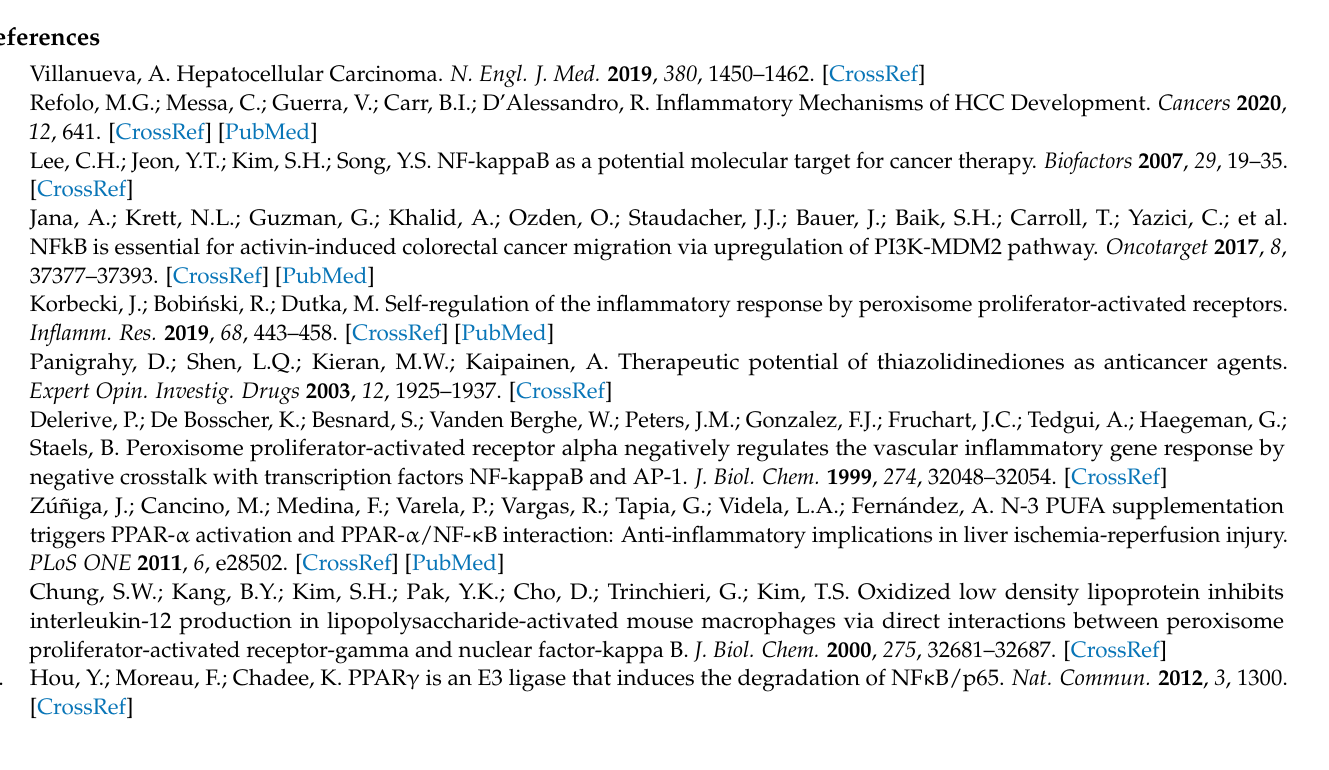
S2: Reagents used for cytoplasmic and nuclear fractions; Table S3: Antibodies list employed in the different methodologies; Table S4: Effect of PFD (30 days at 500 mg/kg), on relative liver weight; Table S5: Effect of PDF (30 days at 500 mg/kg) on serum markers of liver damage (complete)and entire blots from Western Blots presented in the